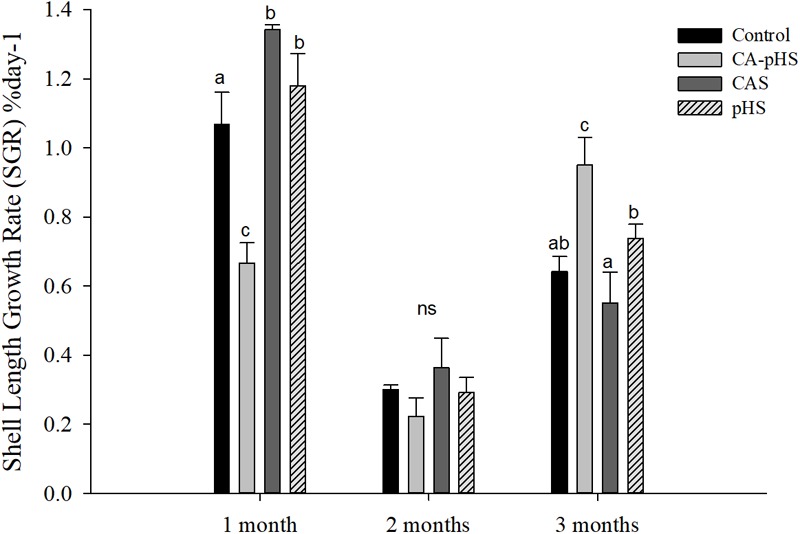
Juvenile of S. constricta shell length growth rate (SGR) in the long-term toxicity test. Bars (mean ± SE, n = 3) with different letters denote significant differences (p < 0.05) among the four groups in each month. The letters “ns” indicate insignificant difference among the four groups in each month.